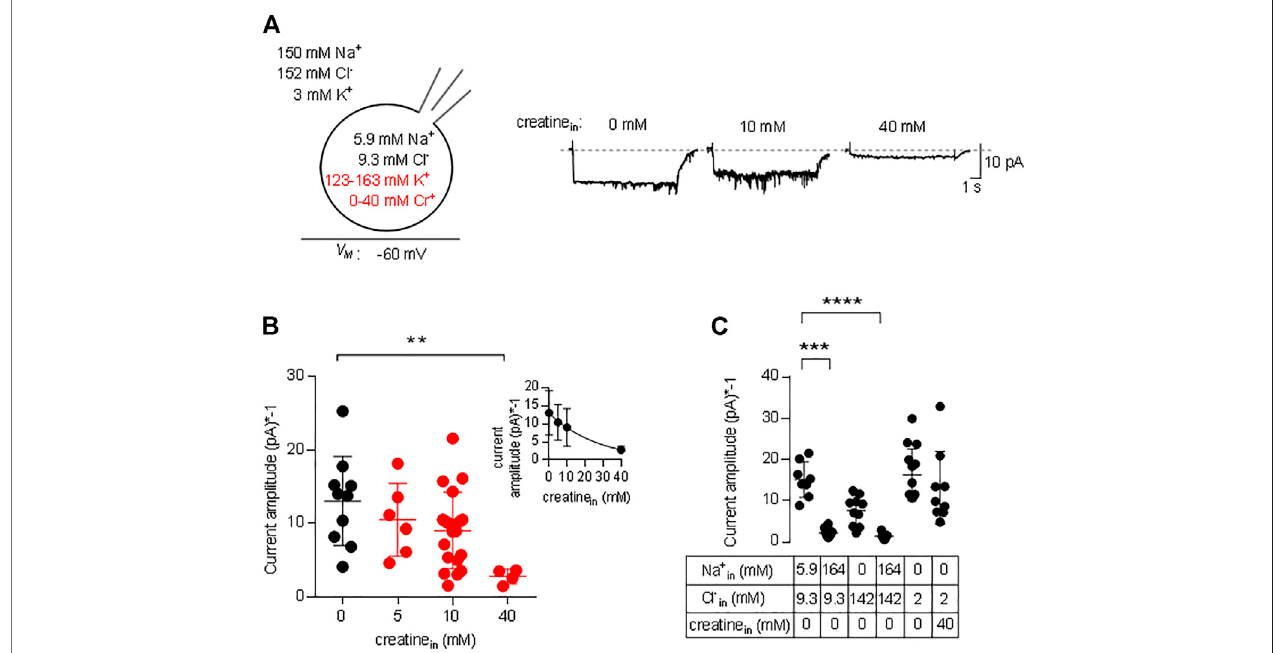
FIGURE 5 | Inhibition by intracellular creatine of currents through CRT-1. (A) The schematic representation on the left hand side illustrates the recording condition, i.e. the extracellular and the intracellular ion concentrations, the variation in intracellular creatine concentration (highlighted in red) and the membrane potential employed in panels A and B. The representative traces shown on the right hand side were recorded from HEK293 cells transiently expressing CRT-1. Currents were elicited by superfusion with 250 µM creatine from cells, which had been fi lled with an internal solution containing 0 mM, 10 and 40 mM creatine. (B) Amplitudes of the steady state current, which was recorded as in panel A in the absence (n = 10) and presence of 5 mM (n = 6), 10 mM (n = 6), 20 mM (n = 19) and 40 mM (n = 5) intracellular creatine. Shown are individual values and means ± S.D. The difference between 0 and 40 mM intracellular creatine was statistically signi fi cant (Kruskal – Wallis test followed by Dunn ’ s post hoc test; p = 0.0055). Inset: The data were also fi tted to the equation for a monophasic inhibition; the resulting estimate for the IC 50 was 16.2 ± 4.3 mM intracellular creatine. (C) Currents were recorded in HEK293 cells transiently expressing CRT-1, which had been fi lled with the indicated concentrations of Na +